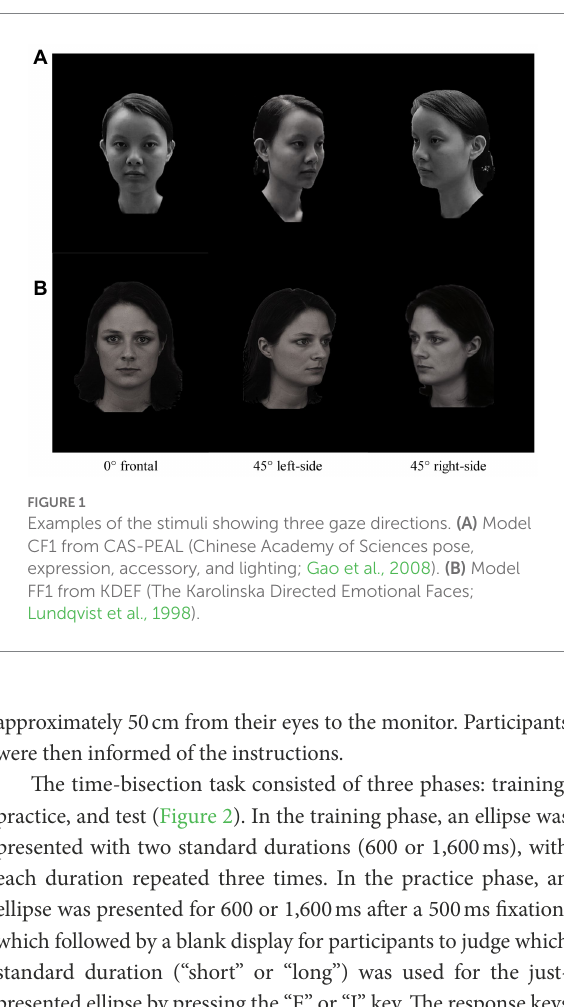
contrast and brightness. Each image measured 360 × 480 pixels.